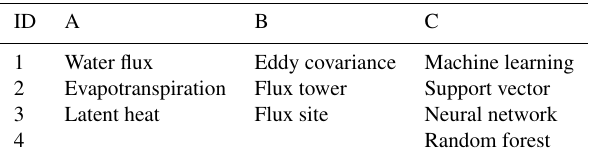
Table 1. Article search: “[A1 OR A2 OR A3 ... ] AND [B1 OR B2